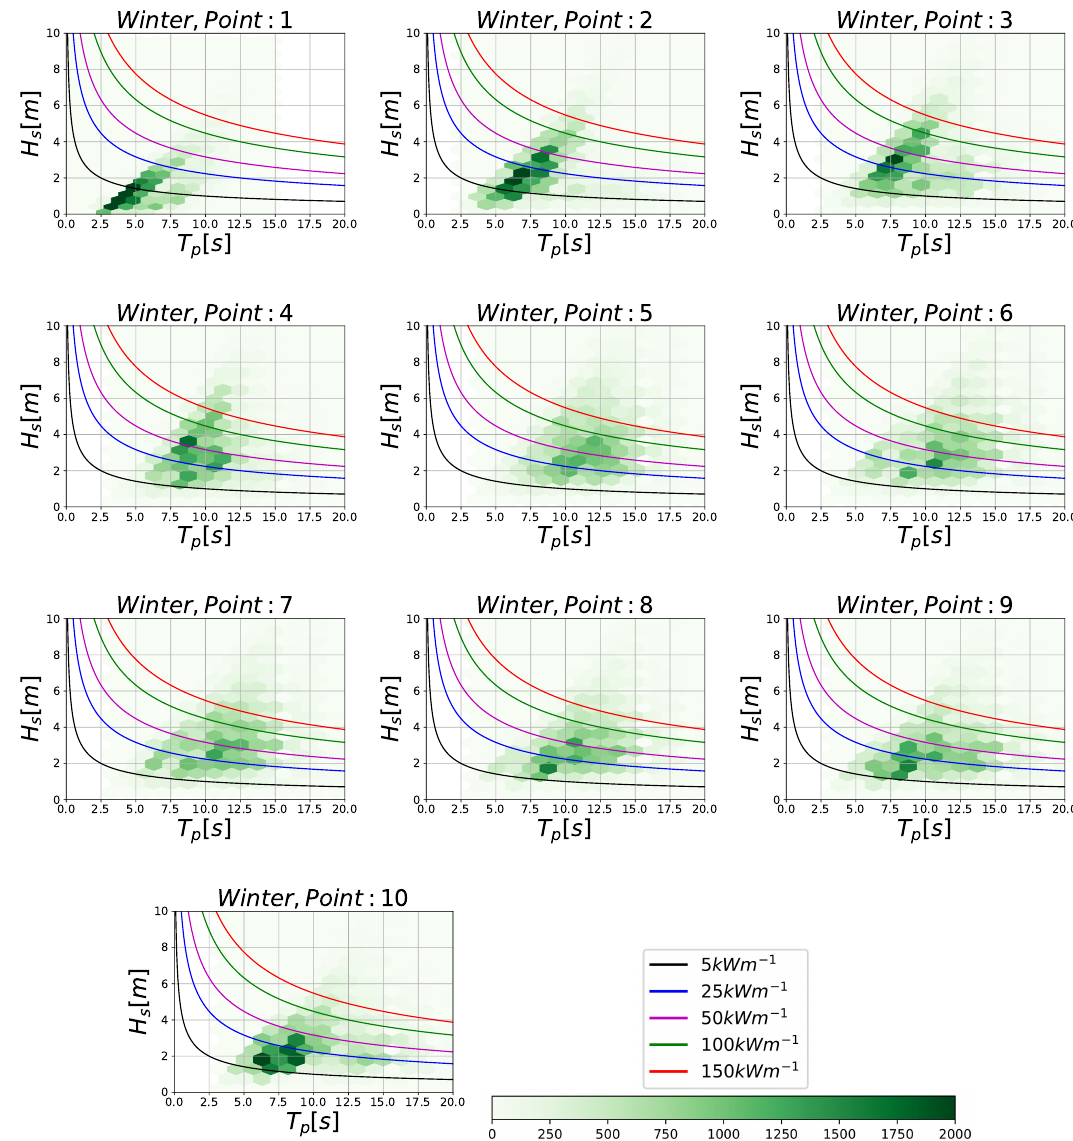
Figure 7. H s - T p diagram of peak wave period (s; x-axis) and total significant wave height (m; y-axis) during the winter season for Points 1–10. Colored areas and contours represent occurrence and WEF (kW m − 1 ),